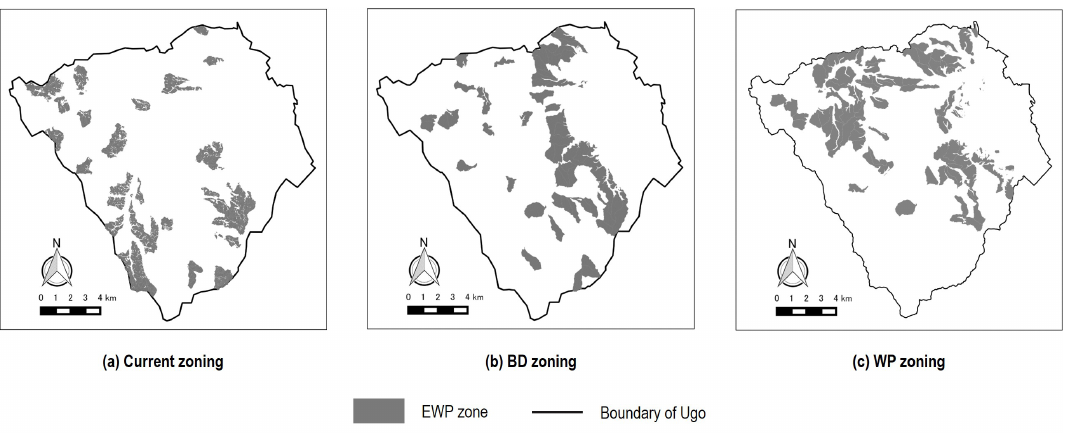
Figure 6. Three zoning alternatives compared in the case